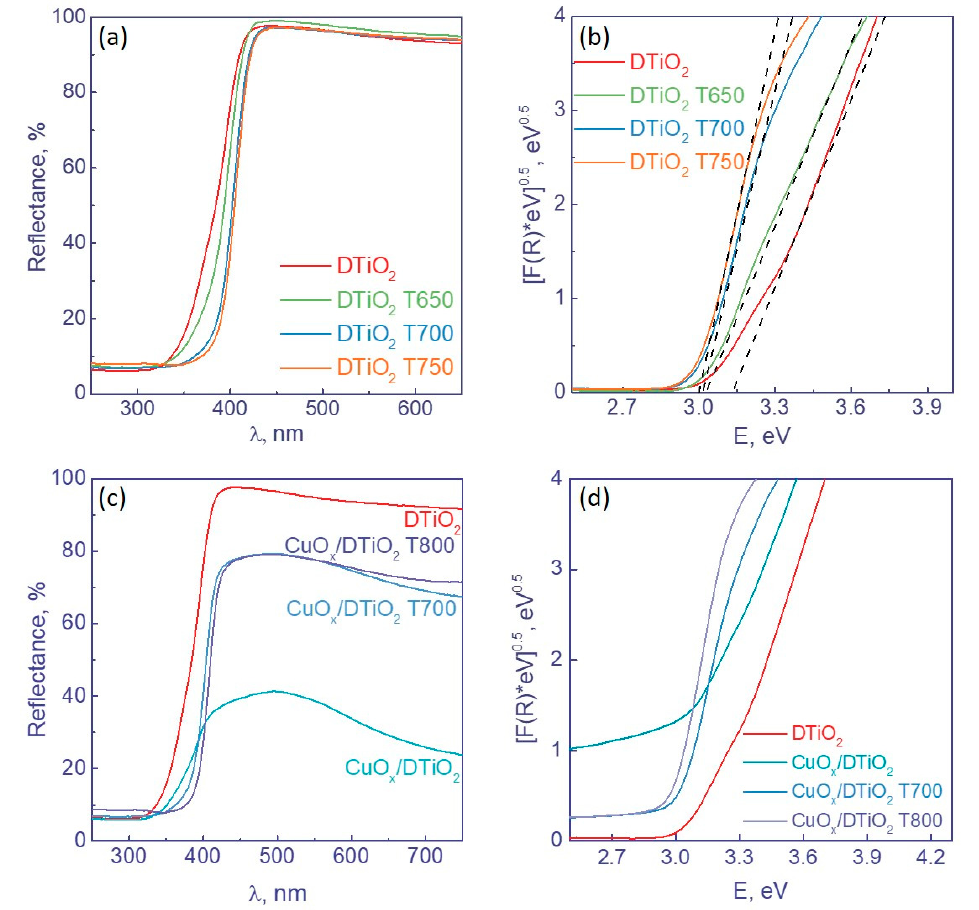
Figure 3. ( a , c ) Diffuse reflectance spectra of photocatalysts and ( b , d ) Tauc plots with tangent to graph (dotted line).